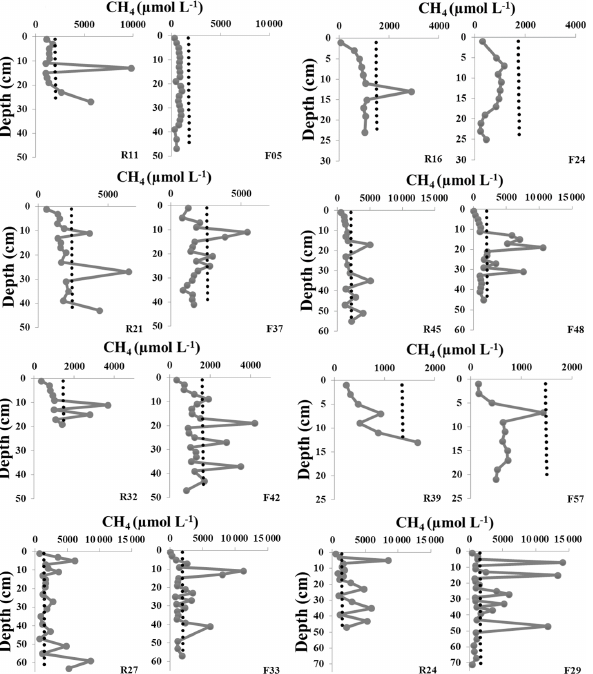
Figure 3. Paired observations of pore water CH 4 profiles during rising-water (R) and falling-water (F) periods at eight different sampling sites across the reservoir. Black lines represent the CH 4 saturation concentration (µmolL − 1 ), and grey lines represent the measured CH 4 concentration (µmolL − 1 ) over sediment depth. The numbers following the letters F and R correspond to the site codes in Table S1.